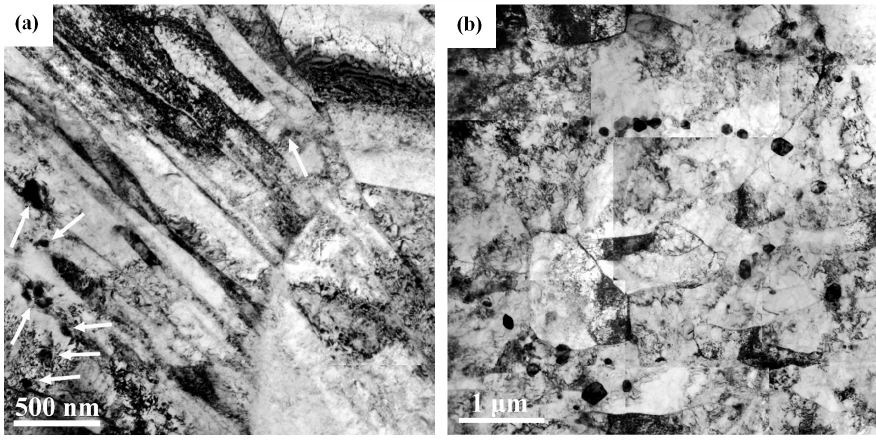
Figure 7. TEM micrographs of the FGHAZ specimen in the: ( a ) as-treated and ( b ) PWHT conditions.